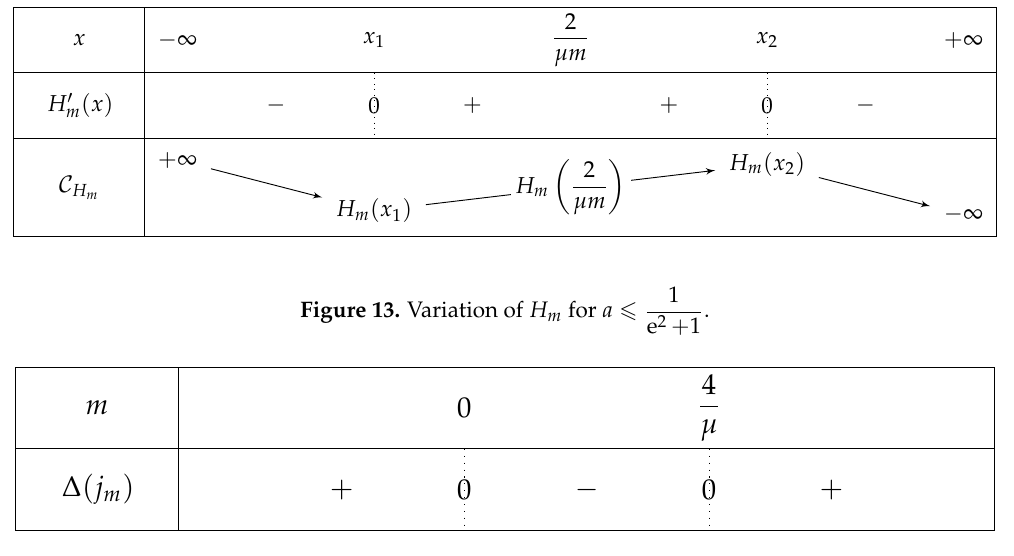
Figure 14. Sign of ∆ ( j m )